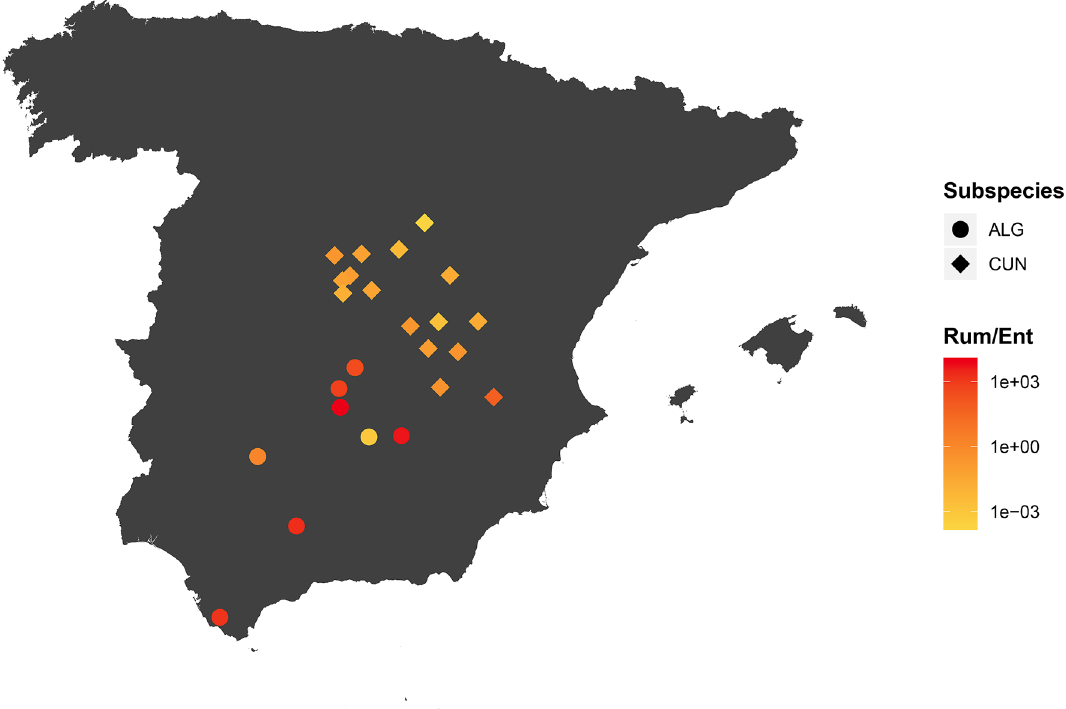
Figure 6. Map of the Iberian Peninsula with the location of field samples and the Ruminococcaceae / Enterobacte riaceae ratio. For the ACCX O. c. algirus population (see Fig. 1), the mean value for 19 independent individuals is shown. Map created with R packages rgdal, v.1.4-8 (https ://cran.r-proje ct.org/web/packa ges/rgdal /), and maptools, v. 0.9-9 (https ://cran.r-proje ct.org/web/packa ges/mapto ols/mapto ols.pdf). Spain shapefile